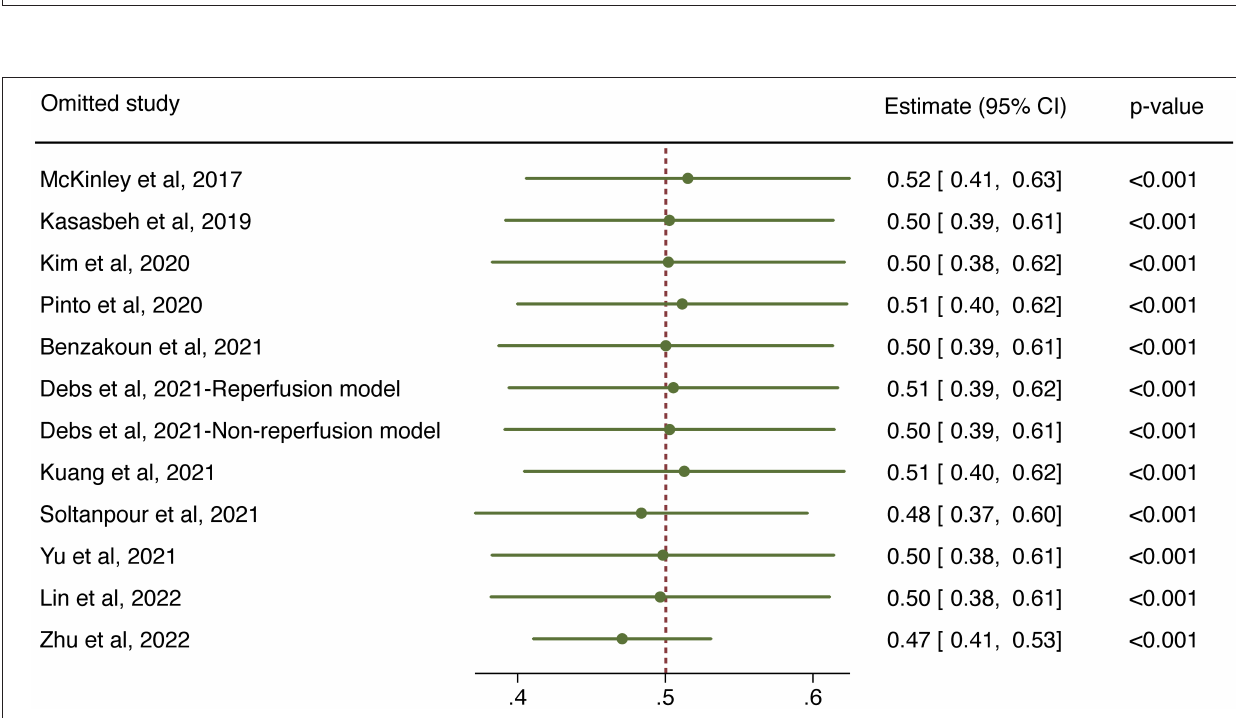
Frontiers in Neurology | www.frontiersin.org